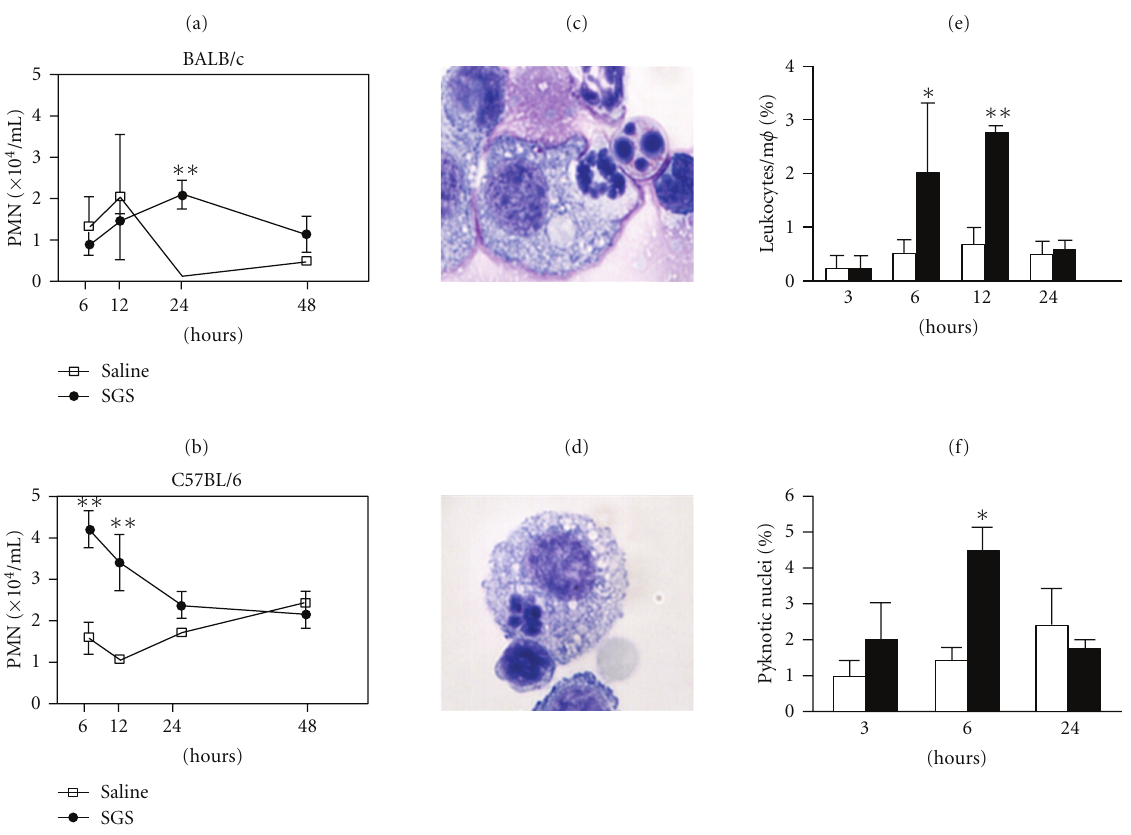
Figure 2: Neutrophil influx, apoptosis, and phagocytosis into BALB/c and C57BL/6 peritoneal cavity in response to L. longipalpis saliva. Mice were injected with endotoxin-free saline or L. longipalpis salivary gland sonicate (SGS) (0.5 pair/animal). After stimulation, peritoneal cavities were washed and di ff erential cell counts were performed on Di ff -Quik stained cytospin preparations. (a-b) Kinetics of neutrophil recruitment in BALB/c (a) and C57BL/6 (b) mice. (c-d) Representative events of C57BL/6 neutrophil phagocytosis by macrophages on Di ff - Quik stained cytospin (magnification 1000x). (e-f) Phagocytosis of C57BL/6 leukocytes by macrophages (e) and neutrophil apoptosis (f) after stimulation with SGS ( • ) or saline ( (cid:2) ). Data shown are from a single experiment representative of three independent experiments. Values represent means ± SEM of five mice per group. ∗ P < 0 . 05 and ∗∗ P < 0 .